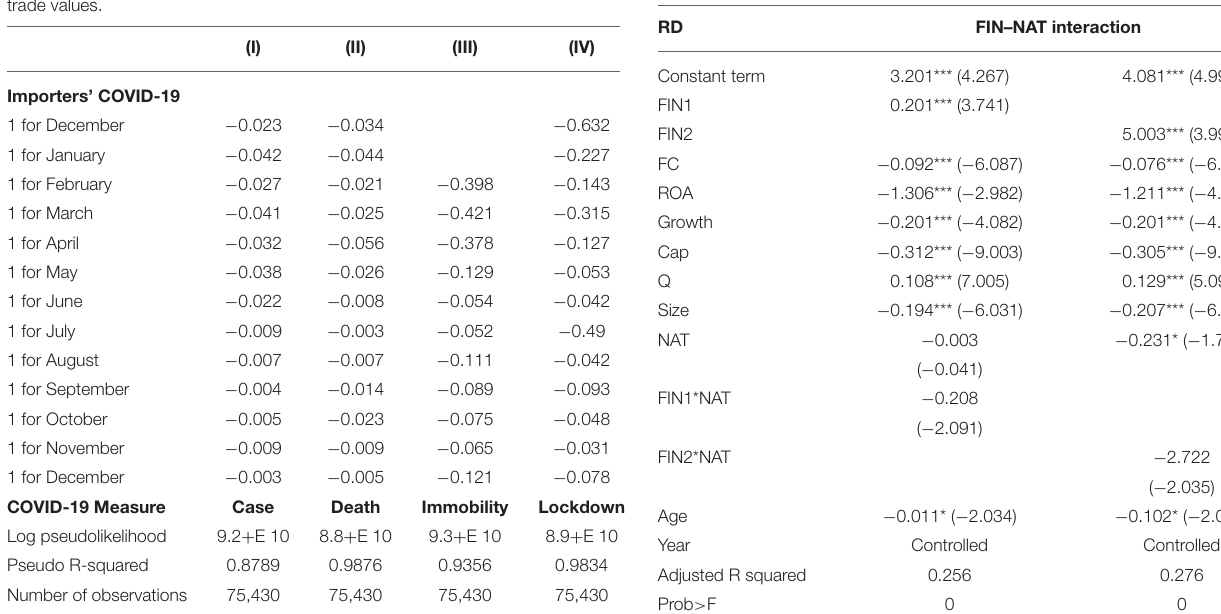
TABLE 9 | Shows the findings of the FIN-NAT relationship and R&D